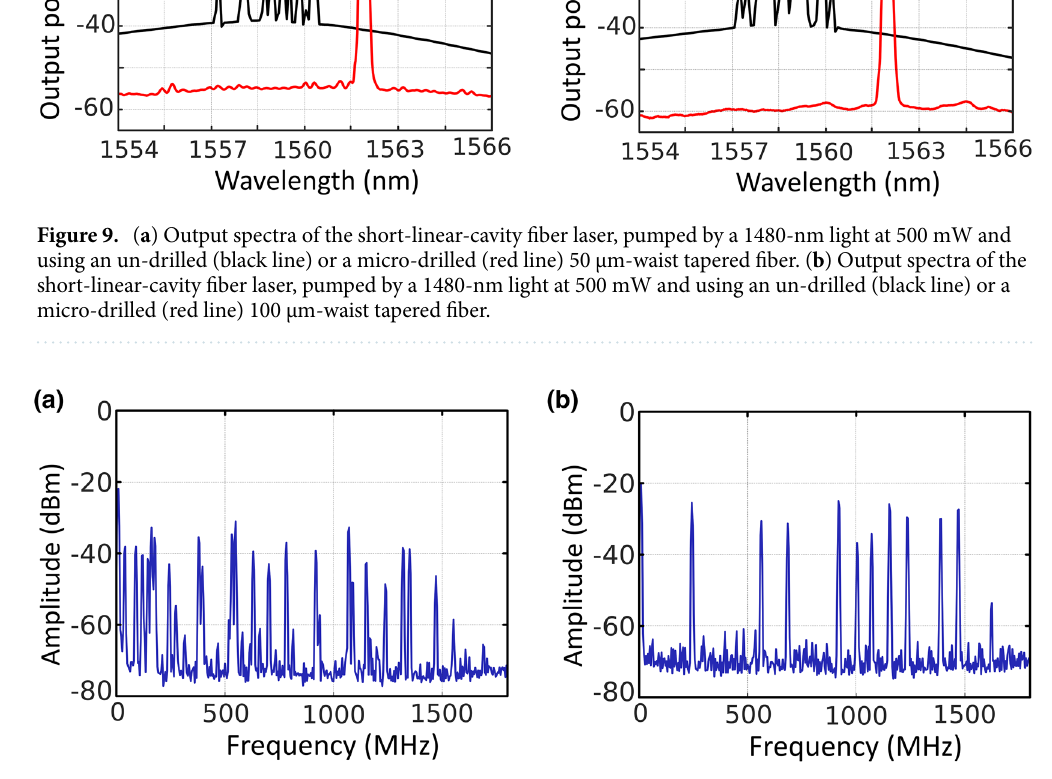
Figure 10. ( a ) Radio-frequency spectra of the beat of the 50 µm-waist tapered fiber with the TLS when pumped at 1480-nm light. ( b ) Radio-frequency spectra of the beat of the 100 µm-waist tapered fiber with the TLS when pumped at 1480-nm